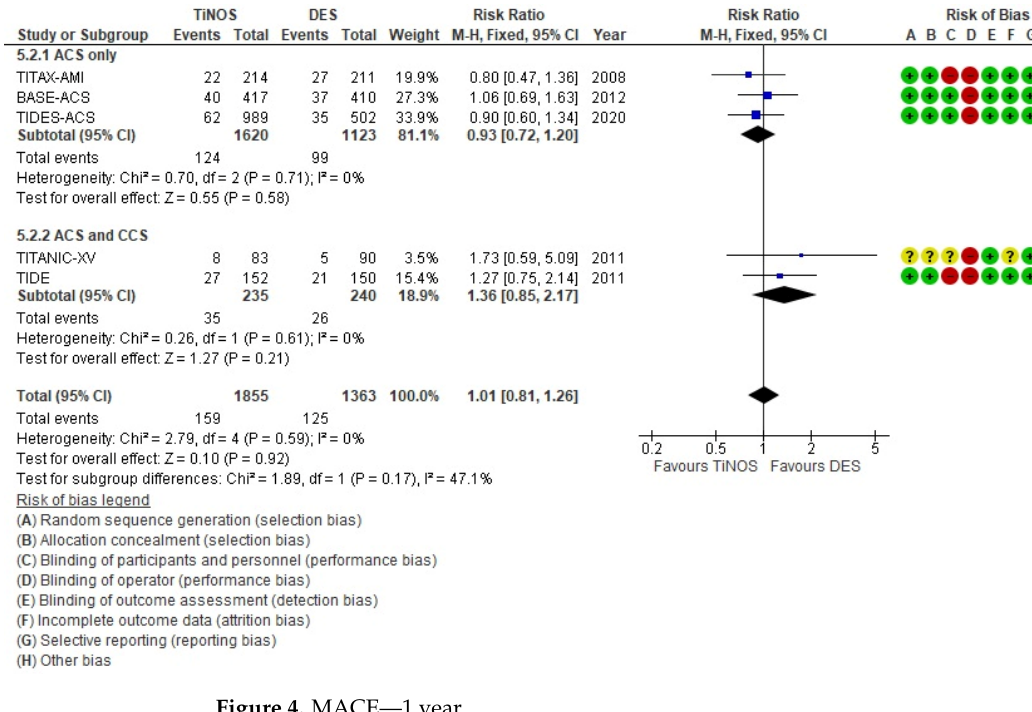
Figure 4. MACE—1 year.